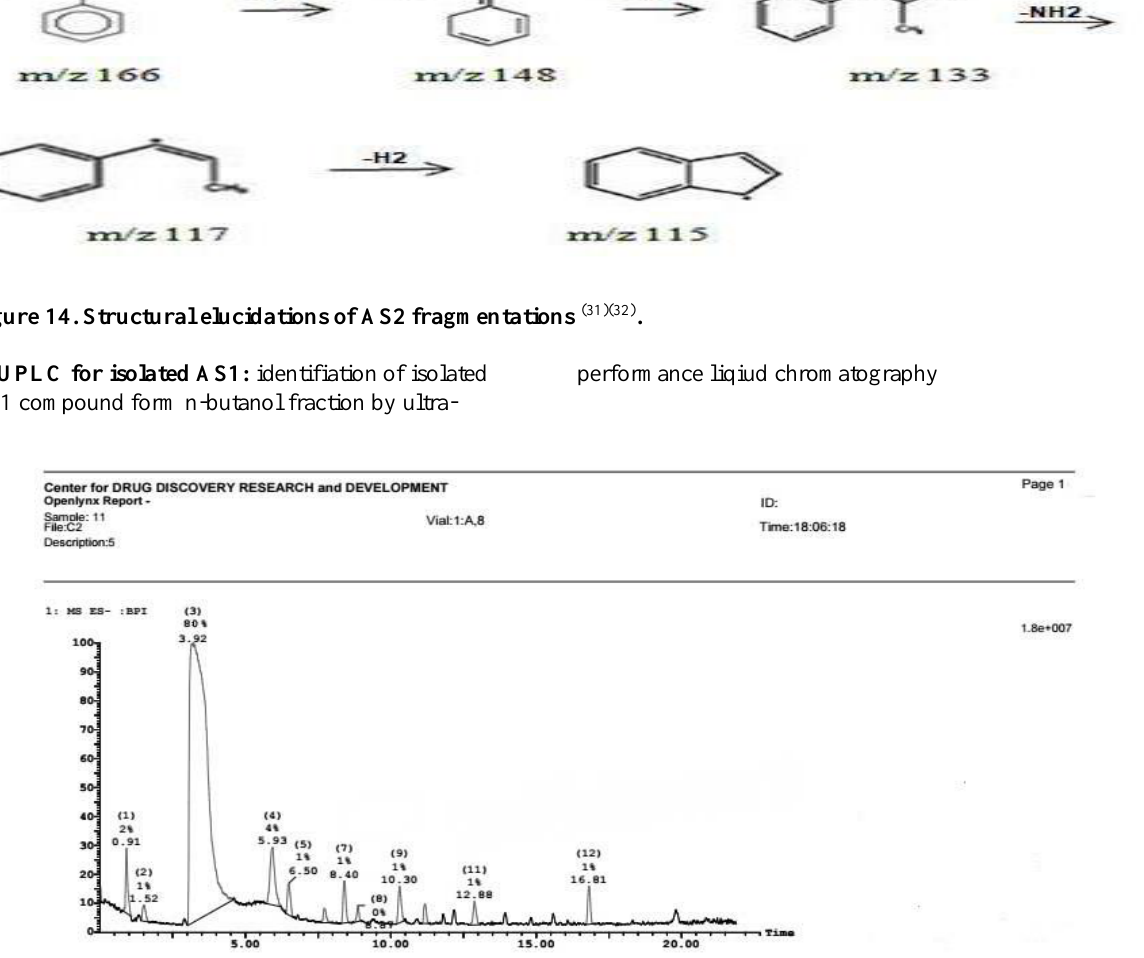
Figure 15. UPLC for isolated AS1 compound from n-butanol fraction before hydrolysis at peak 3.